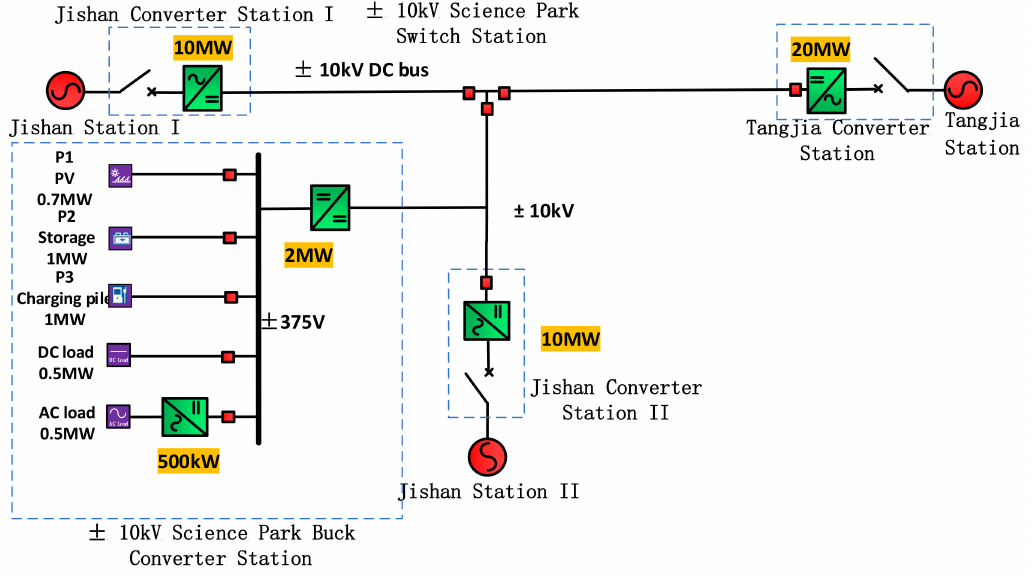
Figure 1. System structure of a flexible DC power distribution